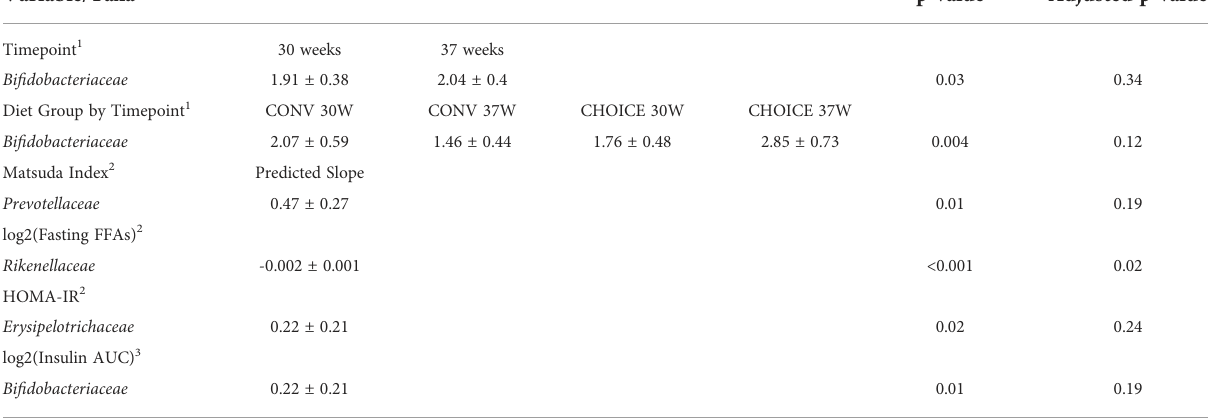
TABLE 3 Variables associated with maternal family-level taxa determined by negative binomial regression.